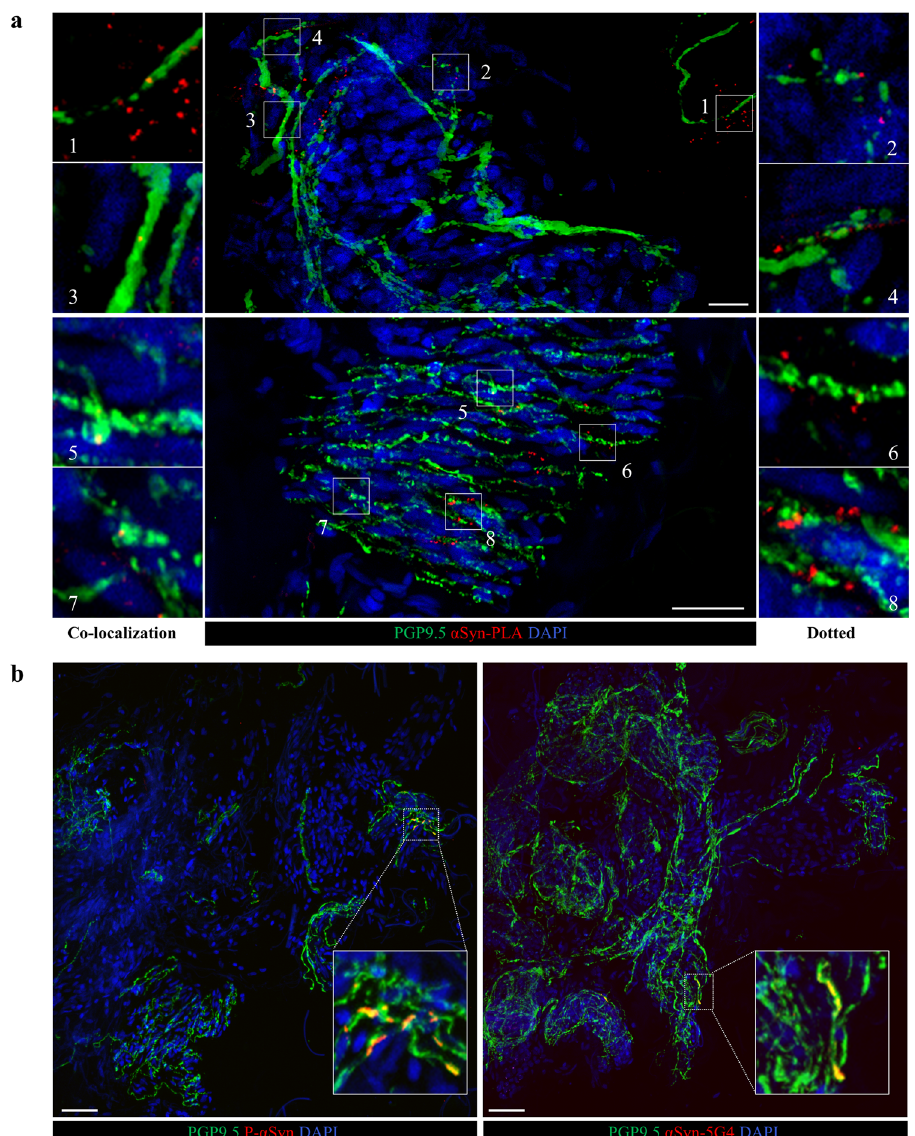
Fig. 2 α Syn PLA, P- α Syn and α Syn-5G4 signals in skin. a Confocal images of a sweat gland (top) and muscle arrector pili (bottom) in skin biopsy at the cervical site of a PD patient: in green the panaxonal marker protein gene product 9.5 (PGP9.5), in red α Syn oligomers detected by proximity ligation assay (PLA) technique. The Co-localization signal of α Syn-PLA and nerve fi bers (magni fi cation on the left) was de fi ned by a yellow signal. The dotted signal (magni fi cation on the right) was de fi ned by an α Syn-PLA signal in the proximity of degenerating nerve fi bers, characterized by swelling and fragmentations, or interposed between nerve fi ber breakpoints. Scale bar 50 µm. b Confocal images of sweat glands in cervical skin biopsy of a PD patient. In red, on the left phosphorylated α Syn, and on the right aggregated α Syn detected by 5G4 antibodies. Co-localization of P- α Syn/PGP9.5 and α Syn-5G4/PGP9.5 is shown in yellow. Scale bar 50